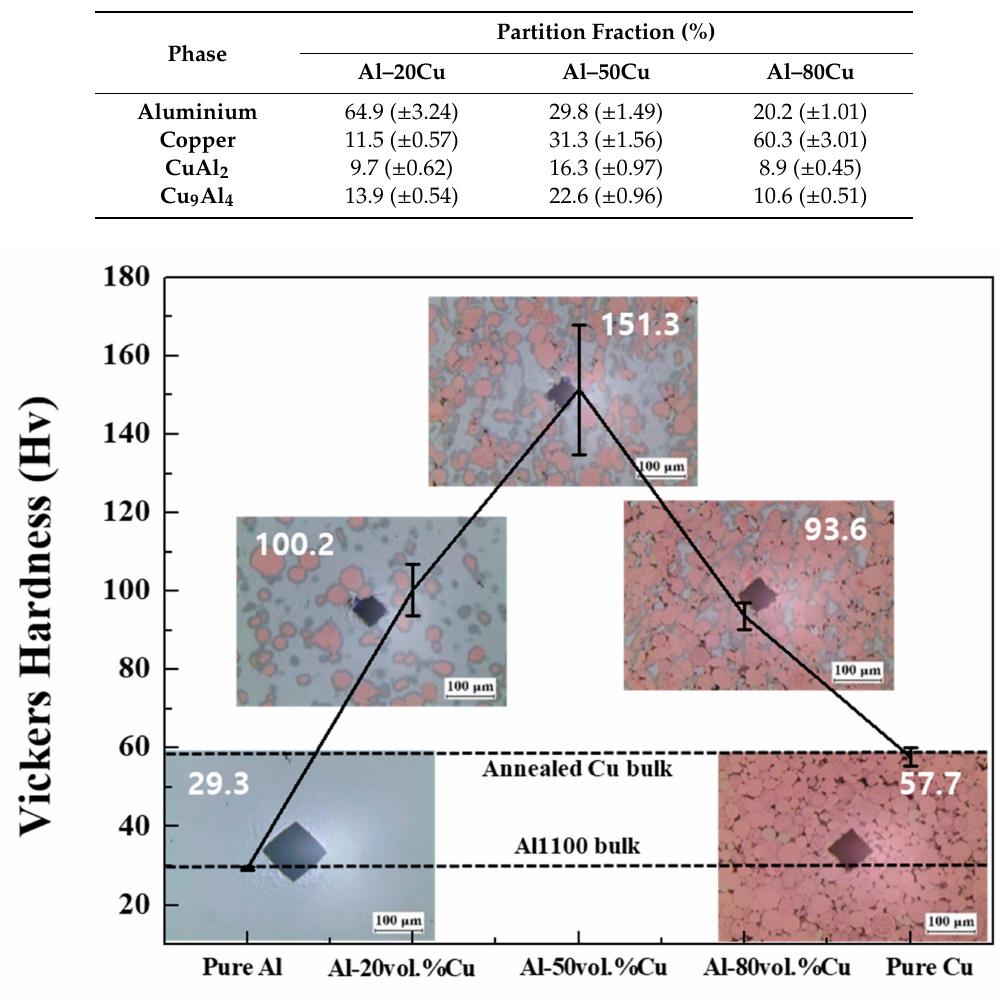
Table 1. Area fraction analysis results for CuAl 2 and Cu 9 Al 4 in the Al–Cu composites.